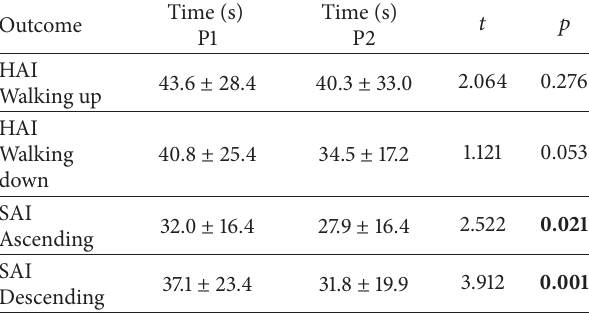
Table 3: Uphill and downhill times in Hill Assessment Index (HAI) and going up and down times in Stairs Assessment Index (SAI) during the first (P1) and the second (P2) phases of evaluation, compared using two-tailed paired 𝑡 -test. Values are expressed as mean ± standard deviation (SD); 𝑡 and 𝑝 values (significant in bold) are